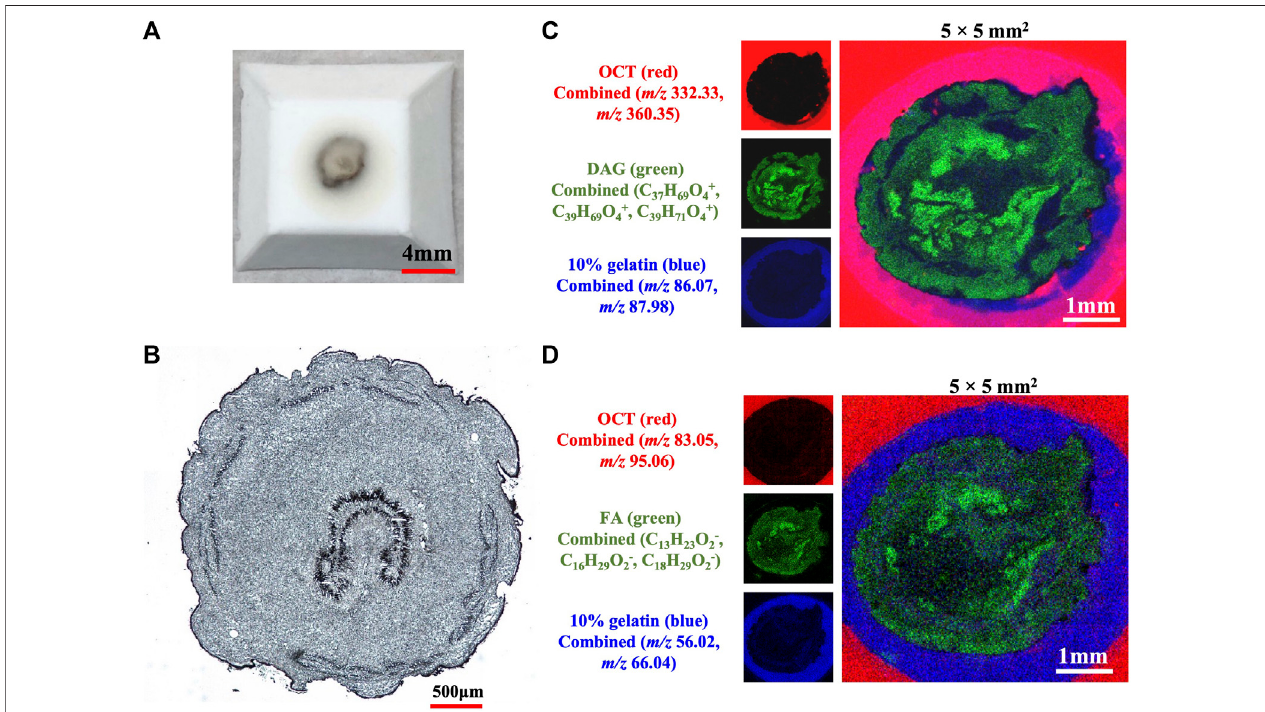
FIGURE1| Thesamplepreparedwithadouble-layeredmediaembeddingmethod (A) Thesolidblock (B) Thecompletesamplesliceunderamicroscope (C) MSIs demonstratingtheoverlayofionsofOCT,10%gelatinandDAGsinpositivemode (D) MSIsexhibitingtheoverlayofionsofOCT,10%gelatinandFAsinnegativemode. The sample block embedded with 10% gelatin and OCT was frozen in the pre-cooled iso-pentane.